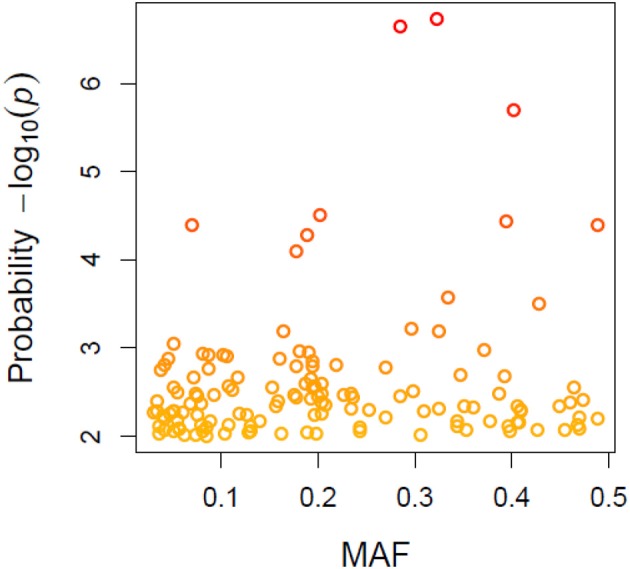
Minor allele frequency (MAF) patterns relative to allele calls for wheat genotypes based on 21073 SNPs.